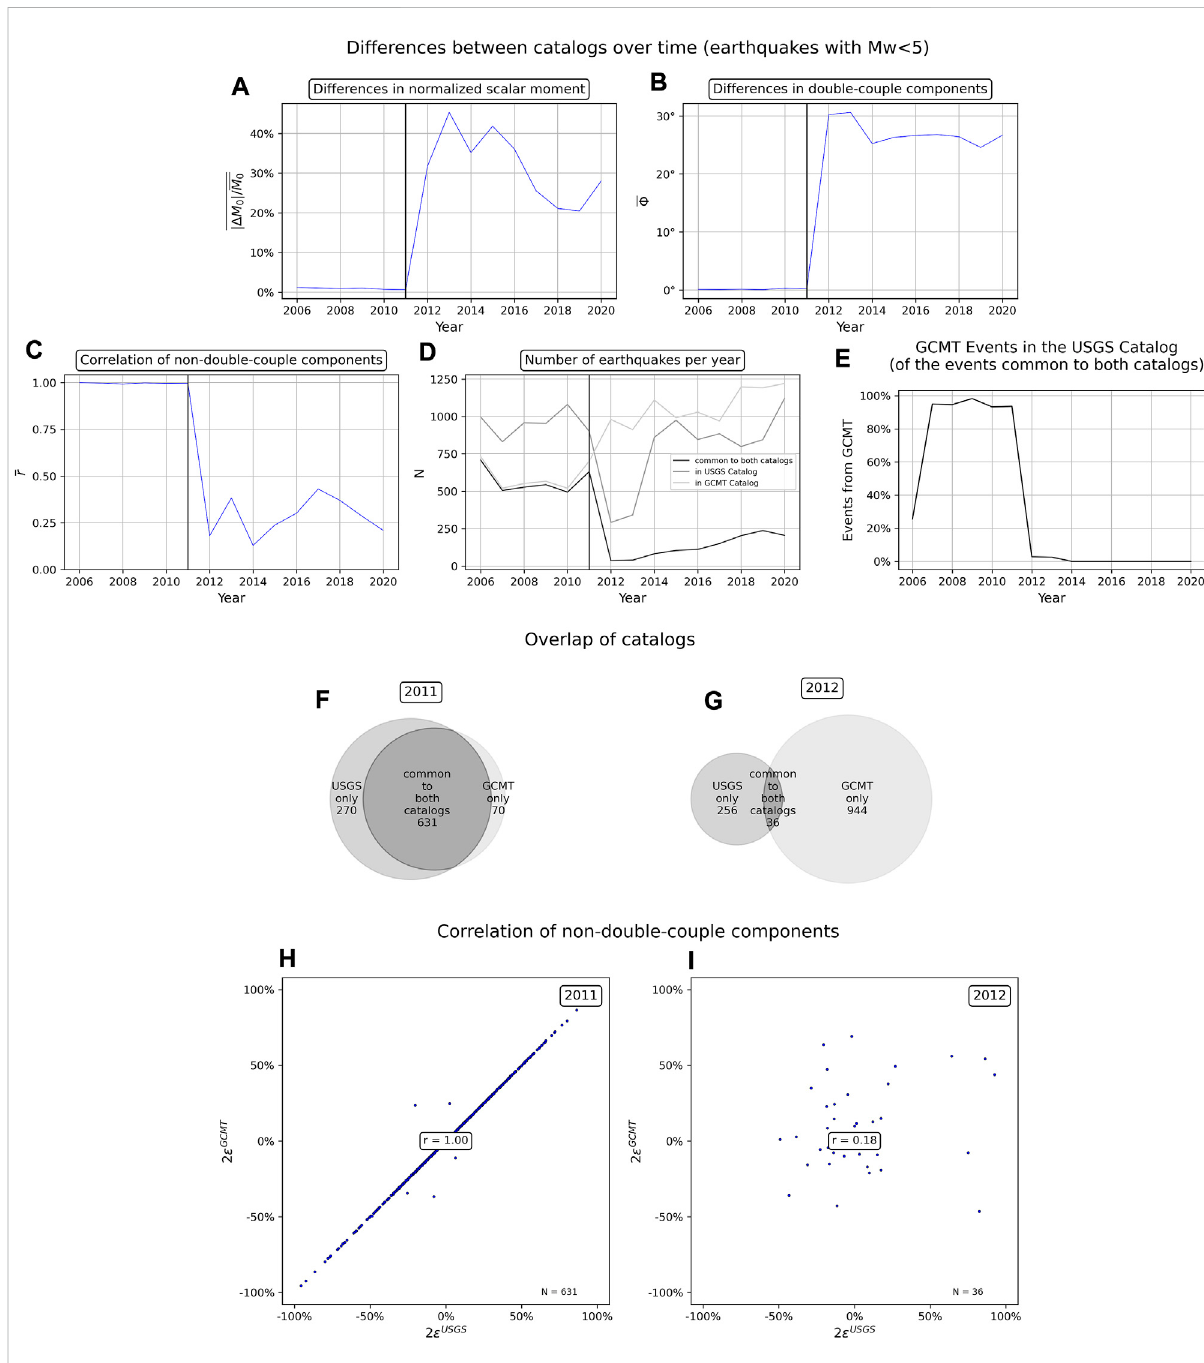
FIGURE 2 Differences in normalized scalar moment (A) , in double-couple components (B) , and correlation of non-double-couple components (C) between USGS and GCMT catalogs over time. (D) Number of earthquakes in each catalog over time and number of earthquakes common to both catalogs. (E) Number of events obtained from the GCMT catalog in the USGS catalog common to both catalogs over time. (F,G) Number of events common to both catalogs and number of events unique in both catalogs in 2011 and 2012. (H,I) Correlation of NDC components between catalogs in 2011 and